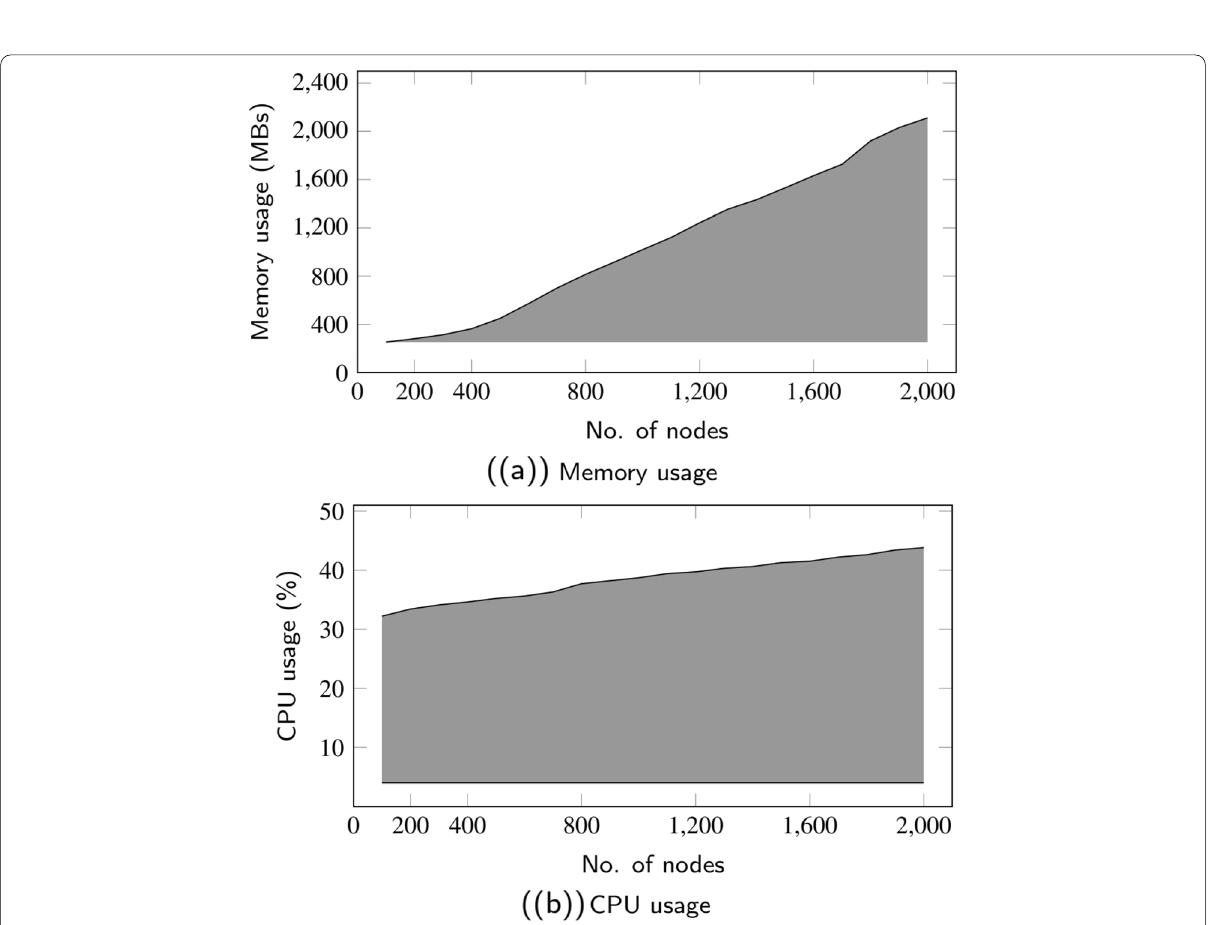
Fogs Cloud Network + + +